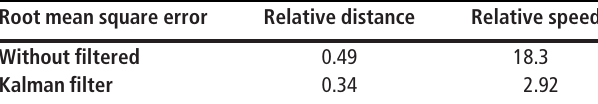
Table 1 RMSE of relative distance and speed